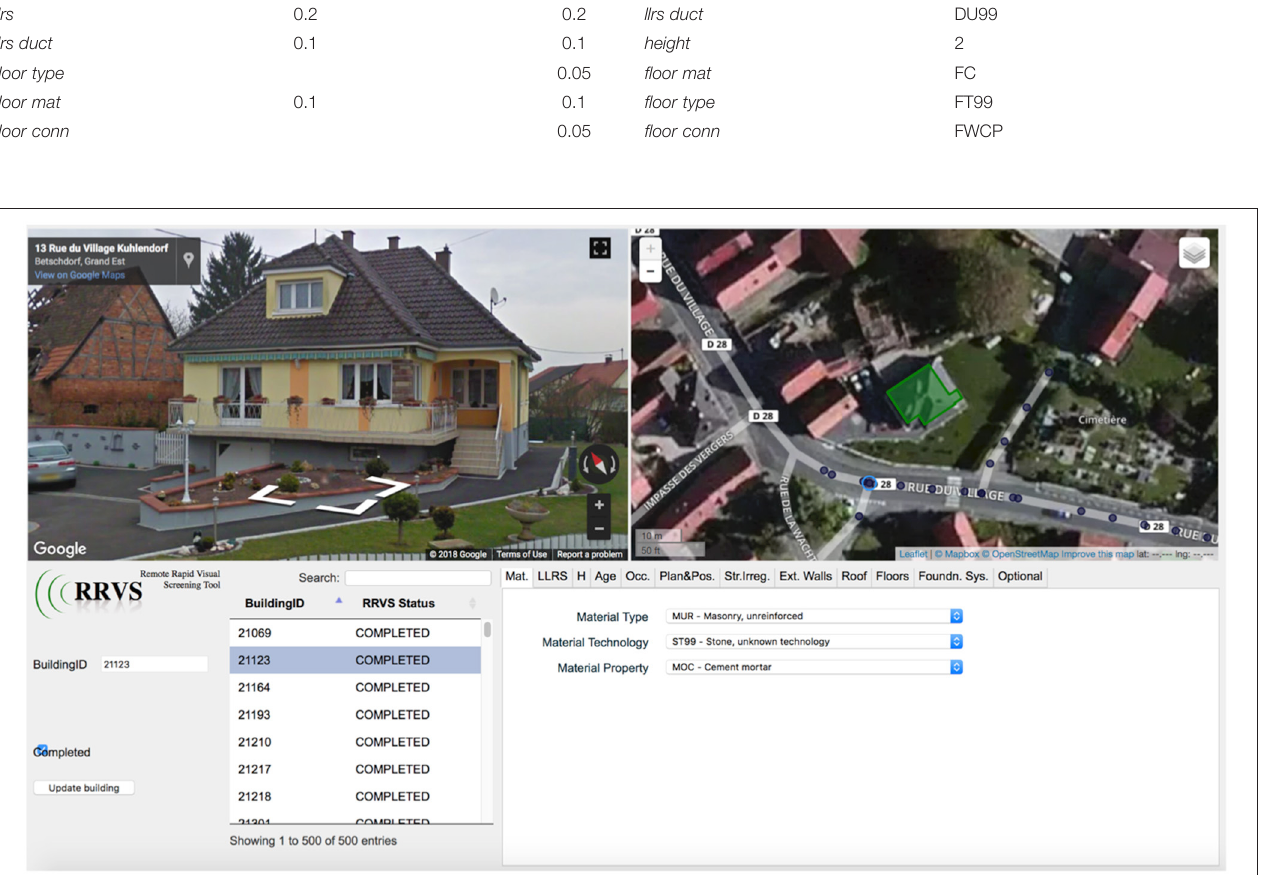
FIGURE 5 | Example of a building remotely inspected using the web-based RRVS platform. The tab panel in the lower right side of the graphical interface includes the principal attributes of the GEM taxonomy. In foreground the material tab. The attributes collected for this building are summarized in Table 7 .